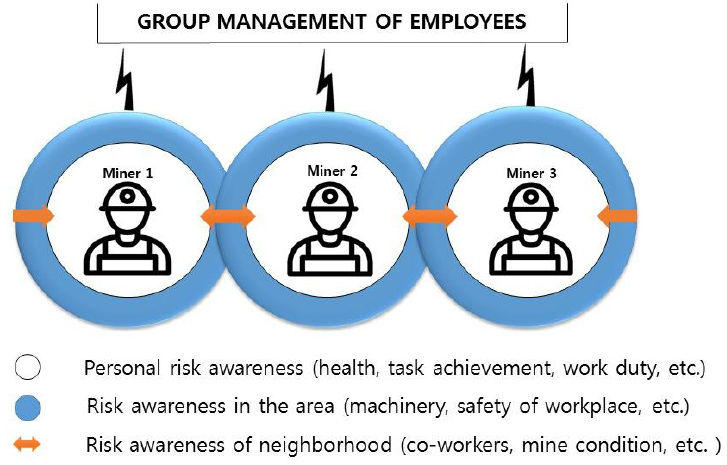
Figure 6. Group management and improved risk awareness among miners.